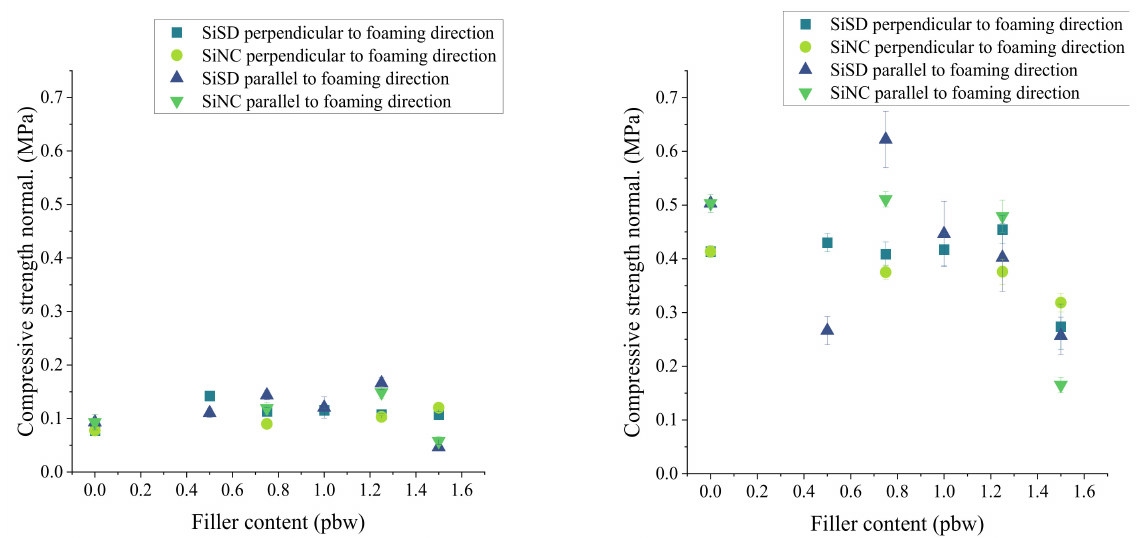
Figure 14. The compressive strength of PP40 composites with 0.5–1.25% filler concentration at RT ( left ) and 77 K ( right